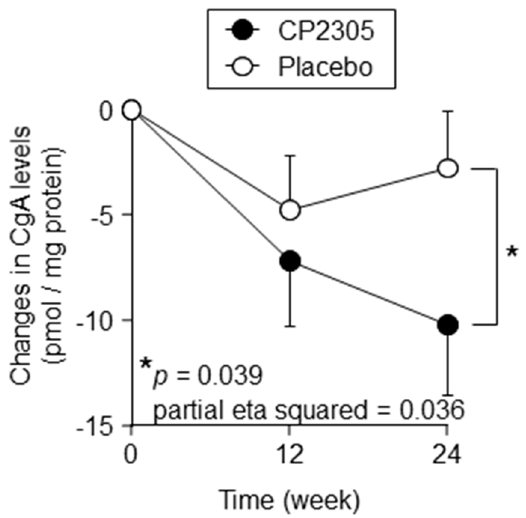
Figure 2. Effects of CP2305 on time-dependent changes in salivary chromogranin A (CgA) levels. Saliva was collected at a constant time within 3 days before and 12 or 24 weeks after the intervention start. Data are presented as the mean ± SEM. Black circles are indicative of CP2305 and the white circles of placebo. Data were analyzed by repeated-measures ANOVA between the groups without multiple comparison correction. p and partial eta squared values are shown in the panel. Asterisks indicate overall significance between the groups across time points. * p < 0.05.